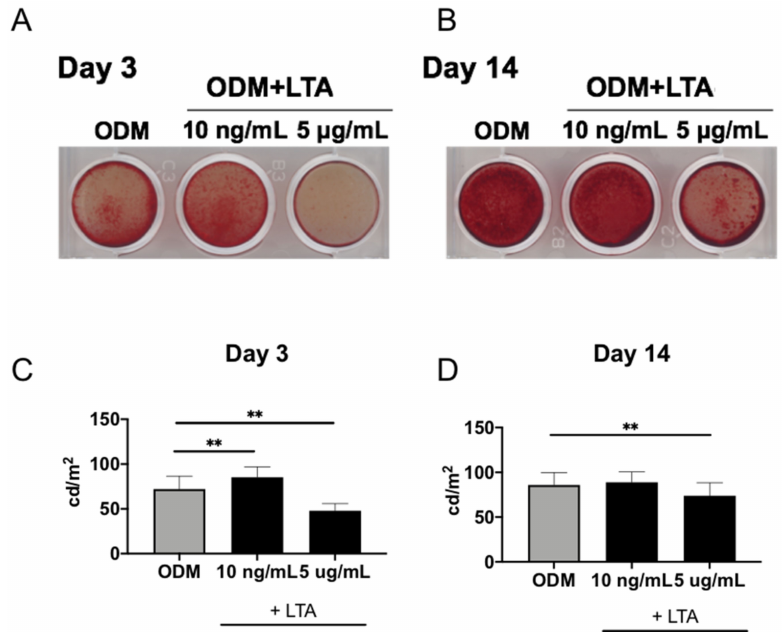
Figure 2. Effects of LTA on MC3T3-E1 osteogenic differentiation. ( A , B ) MC3T3-E1 cells were cultured in an osteogenic induction medium supplemented with or without LTA (10 ng/mL or 5 µ g/mL) for the indicated times. MC3T3-E1 mineralization was investigated by alizarin red staining. ( C , D ) MC3T3-E1 cells were cultured in an osteogenic induction medium supplemented with or with- out LTA (10 ng/mL or 5 µ g/mL) for 3 or 14 days, and then MC3T3-E1 mineralization was measured (n = 3). On day 3, after addition of LTA to the osteogenic induction medium, mineralization was significantly enhanced at 10 ng/mL and significantly inhibited at 5 µ g/mL; on day 14, mineralization was significantly inhibited at 5 µ g/mL, while no change was observed at 10 ng/mL. Results are presented as means ± S.D. ** p <